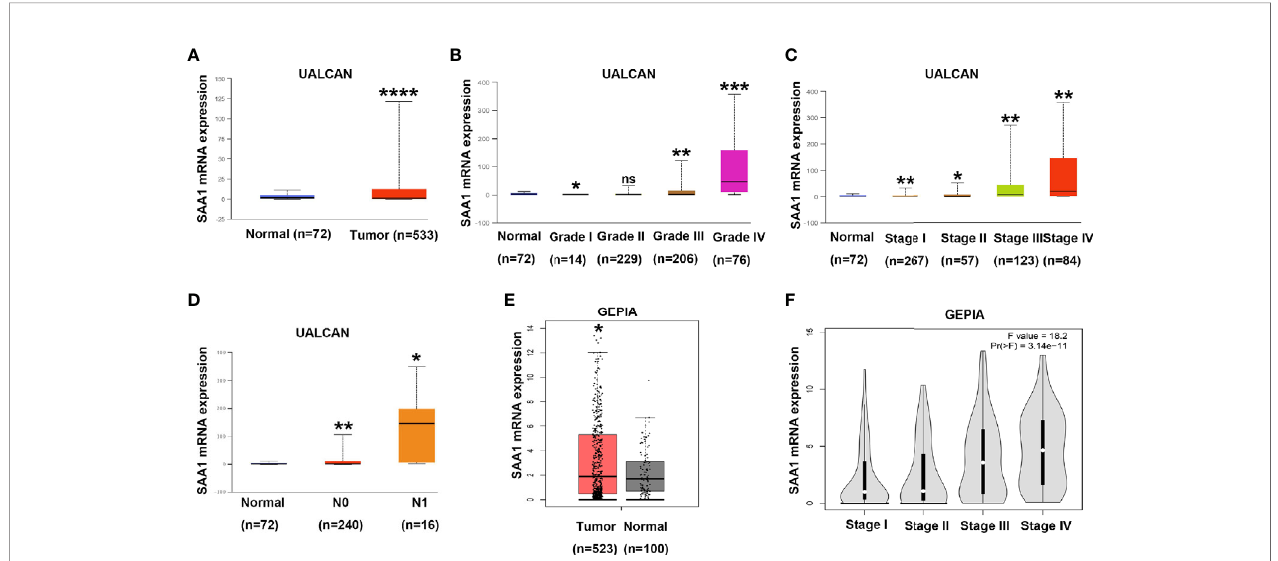
FIGURE 3 | Analysis of SAA1 mRNA expression using UALCAN and GEPIA database. (A) The mRNA expression levels of SAA1 were up-regulated in ccRCC samples from UALCAN database. (B) The expression levels of SAA1 mRNA were compared in tumor grade from UALCAN database. (C) The expression levels of SAA1 mRNA were compared in TNM stage from UALCAN database. (D) The expression levels of SAA1 mRNA were compared in N stage from UALCAN database. (E) The mRNA expression levels of SAA1 were up-regulated in ccRCC samples from GEPIA database. (F) The expression levels of SAA1 mRNA were compared in TNM stage from GEPIA database. (****P<0.0001, ***P<0.001, **P<0.01, *P<0.05, NS means no signi fi cance, compared with the respective